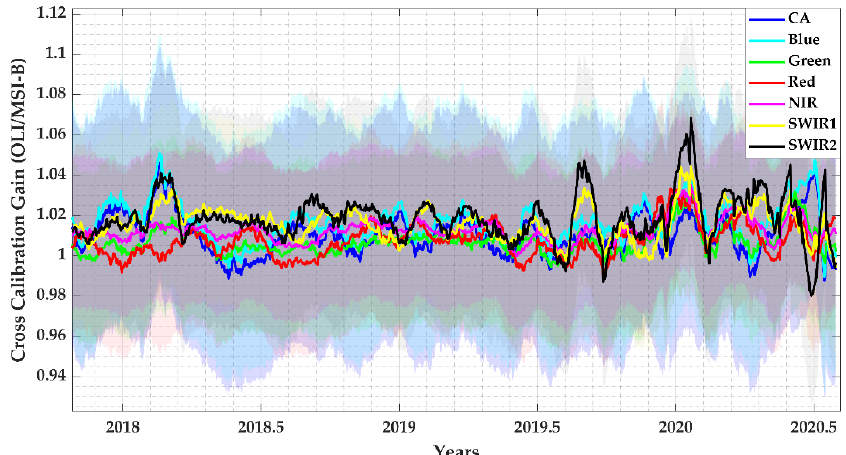
Figure 12. The trend-to-trend cross-calibration gain of Sentinel 2A MSI and Sentinel 2B MSI. The shaded region is the uncertainty for individual bands.